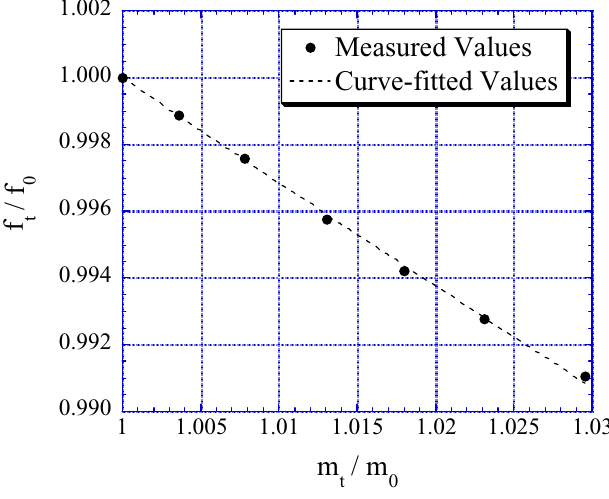
Figure 13. The relative resonant frequency of a magnetoelastic sensor decreases linearly with increasing mass of silver coating. A least square-fit (dashed line) is used to calculate the Young’s modulus of the